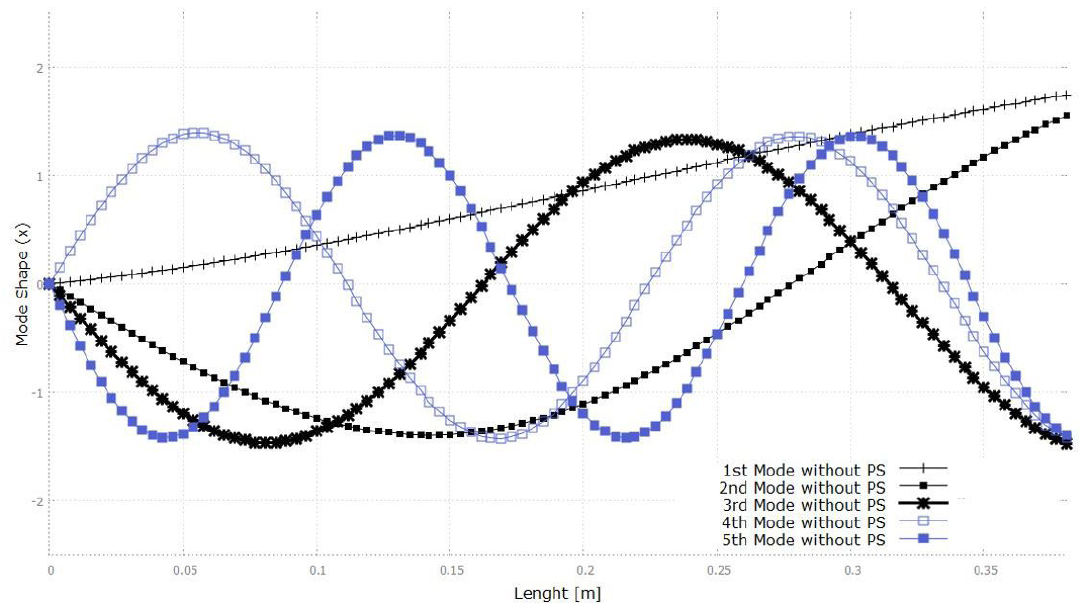
Figure 12. First five transversal mode shapes of the clamped-free (CF) beam computed using the parasitic shear finite element